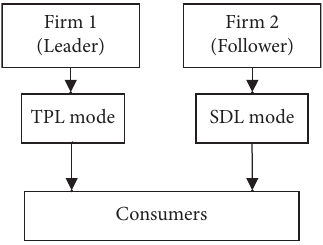
Figure 4: Logistics mode leaders use TPL.